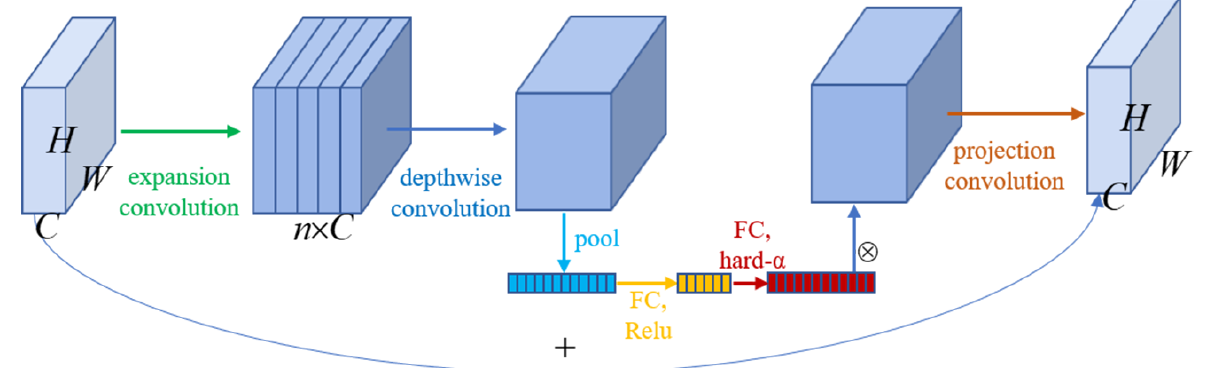
Figure 3. The structure of the bneck in